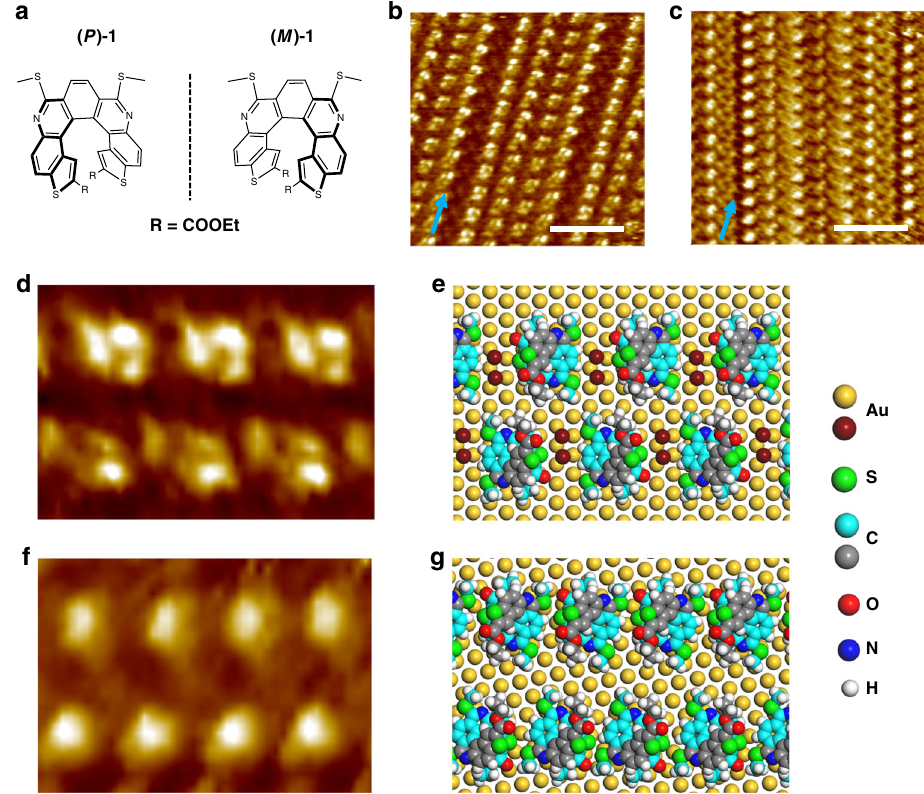
Fig. 3 The helicene-Au complex. a Molecular structures of the two enantiomers of diazadithia[7]helicene, ( P )-1 and ( M )-1. b , c STM images of the linear superstructure of ( P )-1 formed at room temperature ( C = 20 µ M, I set = 100 pA, V bias = -800 mV) and at 4 °C ( C = 20 µ M, I set = 100 pA, V bias = − 900 mV) at the TCB/Au(111) interface, respectively. d – g Close-up STM image (3.5 × 5.0 nm 2 ) and structural model of the linear structure of ( P )-1 formed in a room temperature solution ( d , e ) and at 4 °C ( f , g ), respectively. In the structural models, Au adatoms are dark brown. Carbon atoms are displayed in light blue, except for those of the protruding part of a helicene, which are displayed in grey. The brightest features in the STM images are attributed to the (cid:1) (cid:3) protruding part of the helicene molecules. Equivalent 11 (cid:1) 2 directions of the underlying Au(111) surface are indicated with blue arrows. Scale bars: b , c , 5